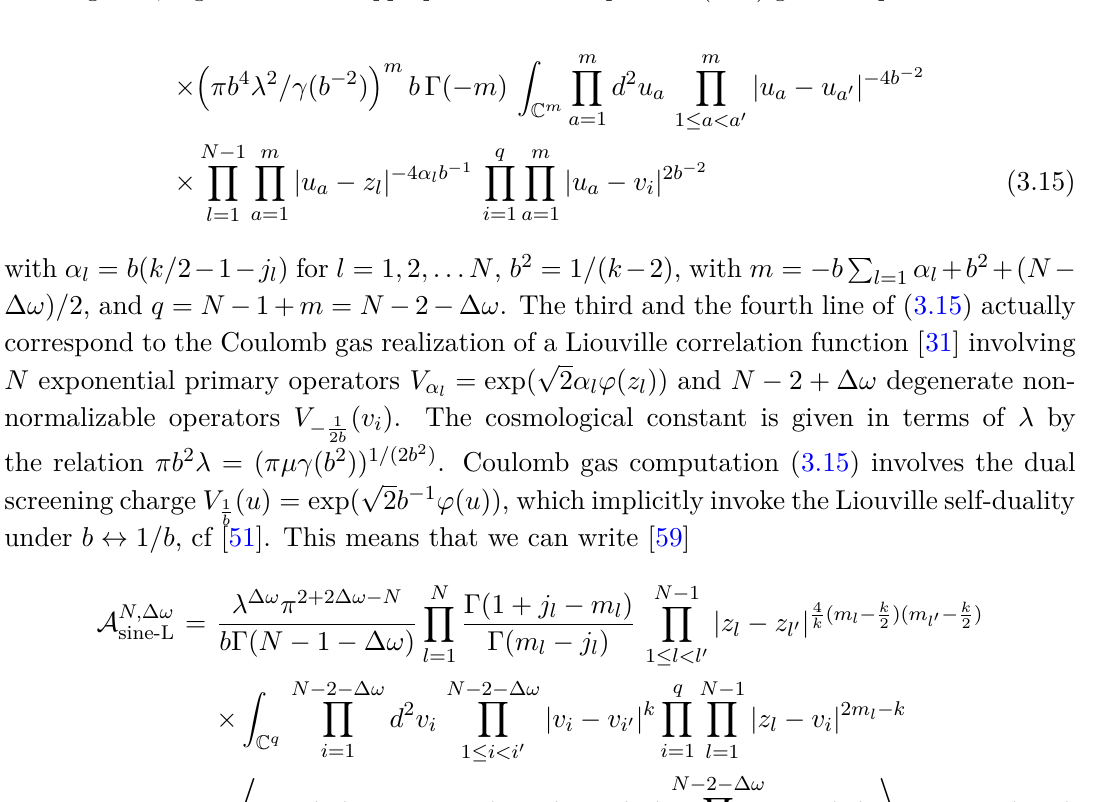
Figure 3 . Scheme of the relation between the N -point functions in sine-Liouville theory and the ( 2 N − 2 −| ∆ ω | )-point function in Liouville field theory, where N − 2 −| ∆ ω | degenerate operators V are integrated, together with an appropriate factor. Expression (3.16) gives the precise